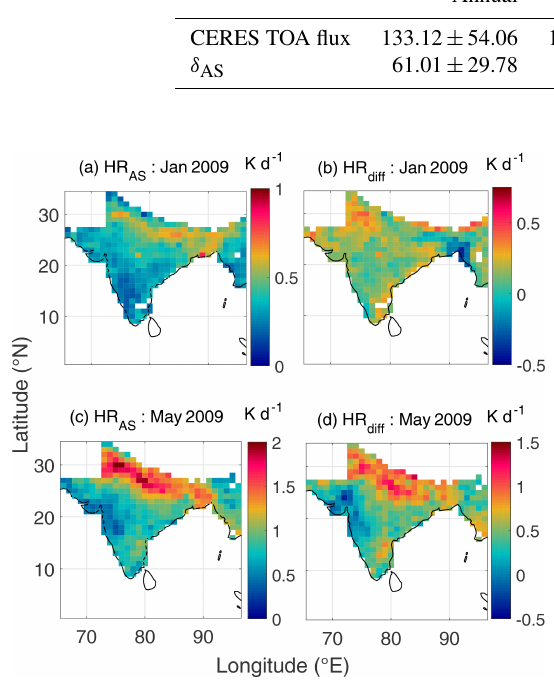
Figure 9. Spatial variation of aerosol-induced atmospheric heat- ing rate (in Kd − 1 ) estimated using assimilated aerosol products (HR AS ) for January and May 2009 ( a and c , respectively), dif- ference between aerosol-induced atmospheric heating rate corre- sponding to assimilated and satellite aerosol products (HR diff = HR AS − HR SR ) for January and May 2009 ( b and d , respectively).